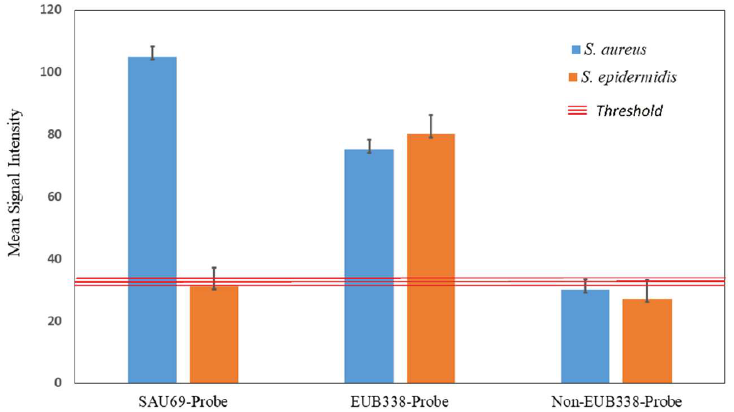
Figure 9. The S. aureus and S. epidermidis labelled with SAU69–BHHTEGST–Eu 3+ , EUB338– BHHTEGST–Eu 3+ and NON-EUB338–BHHTEGST–Eu 3+ , the threshold of the luminescence intensity and standard deviation (SDV) are shown as a mean (n replication = 30) signal intensity (See SI table